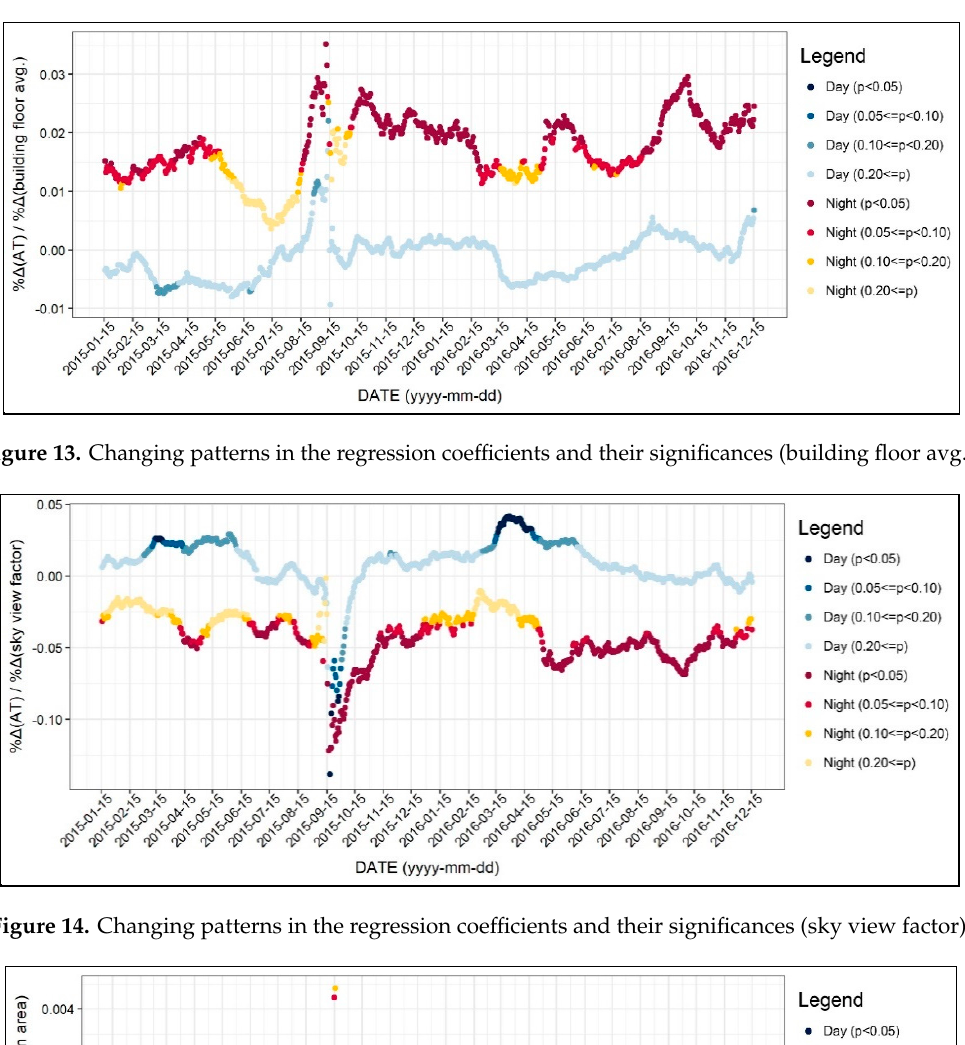
Figure 13. Changing patterns in the regression coefficients and their significances (building floor avg.).